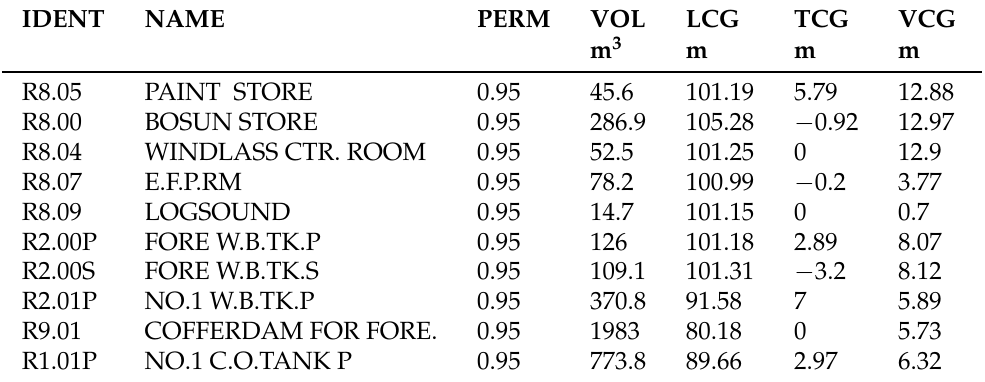
Figure 9. Illustration of damage case DAM09. Table 6. Damaged compartments of DAM04.